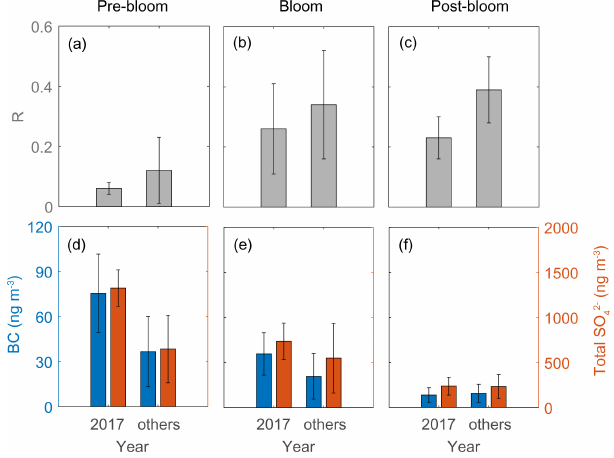
Figure 11. Air mass exposure to chlorophyll ( E Chl ) (a–c) and the 4 air mass residence times over the ocean and marginal ice zone (MIZ) and the multi-year ice and land areas (d–f) during pre-bloom, bloom, post-bloom periods. Error bars represent 1 σ